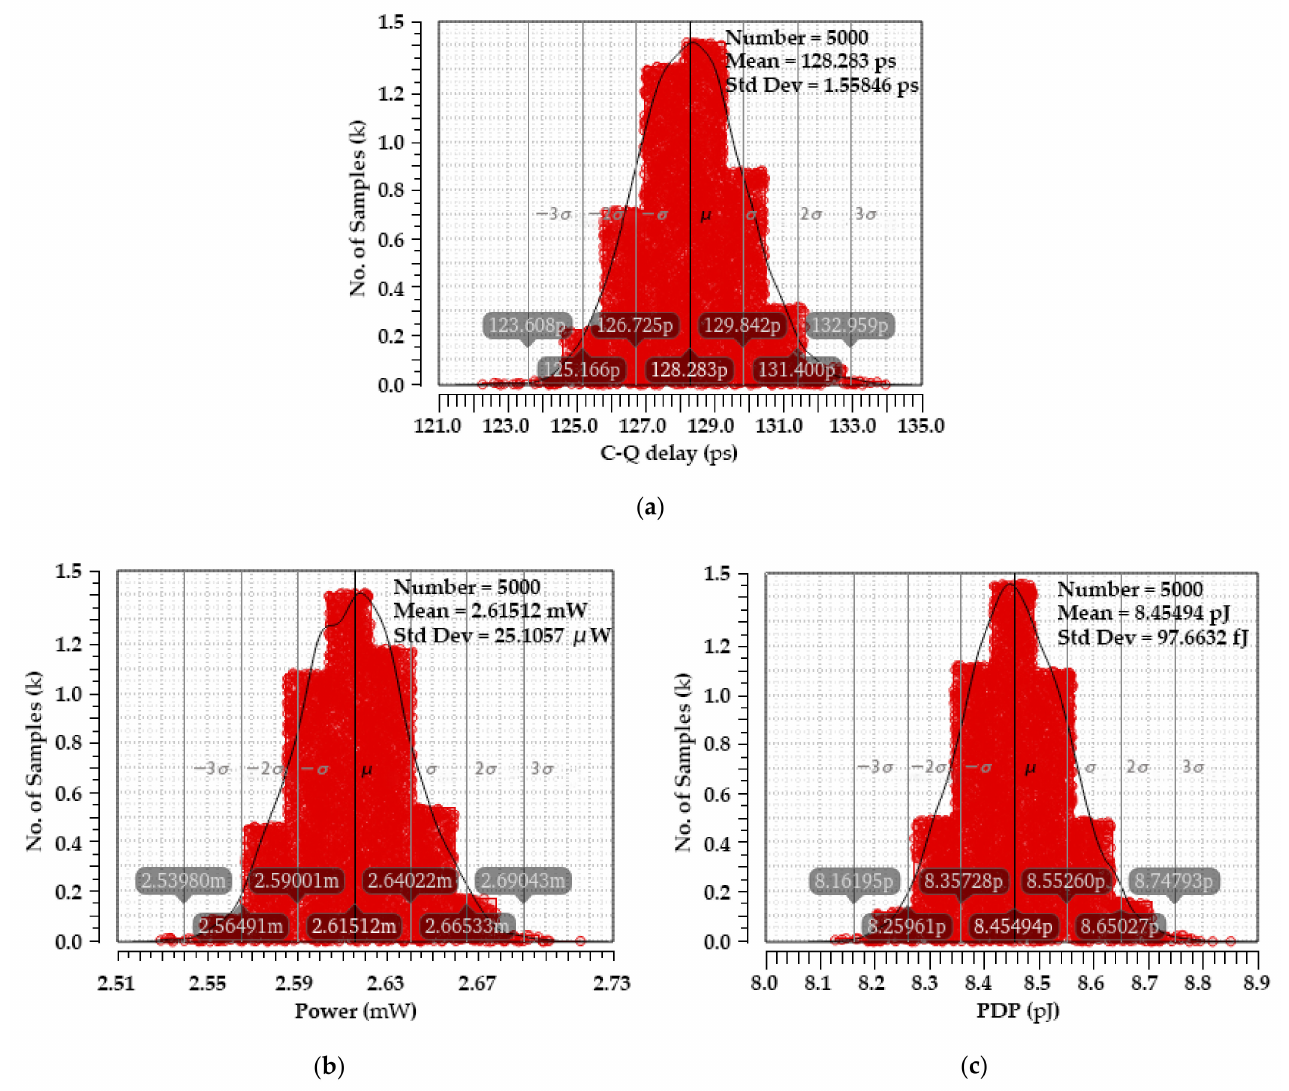
Figure 22. Monte Carlo simulation results of process variation: ( a ) C-Q delay, ( b ) power, and ( c )